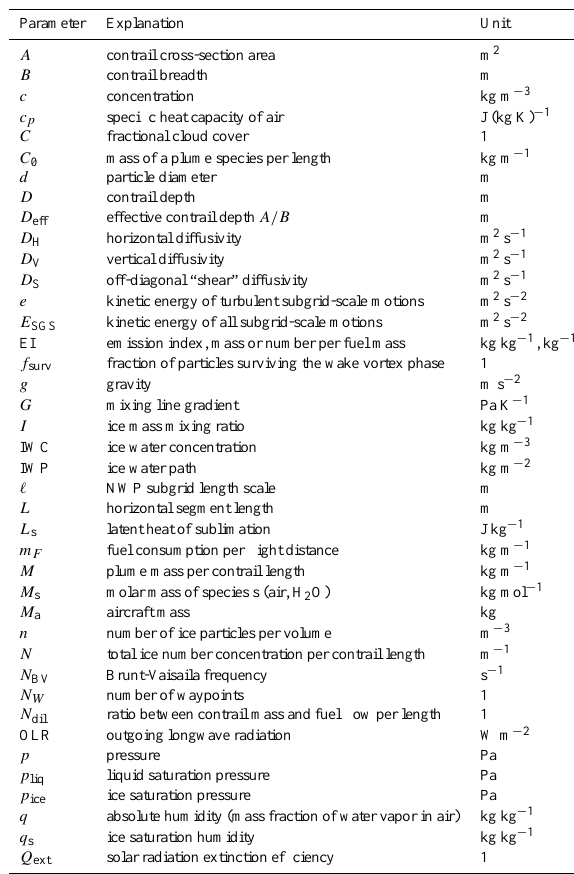
Table A1. List of